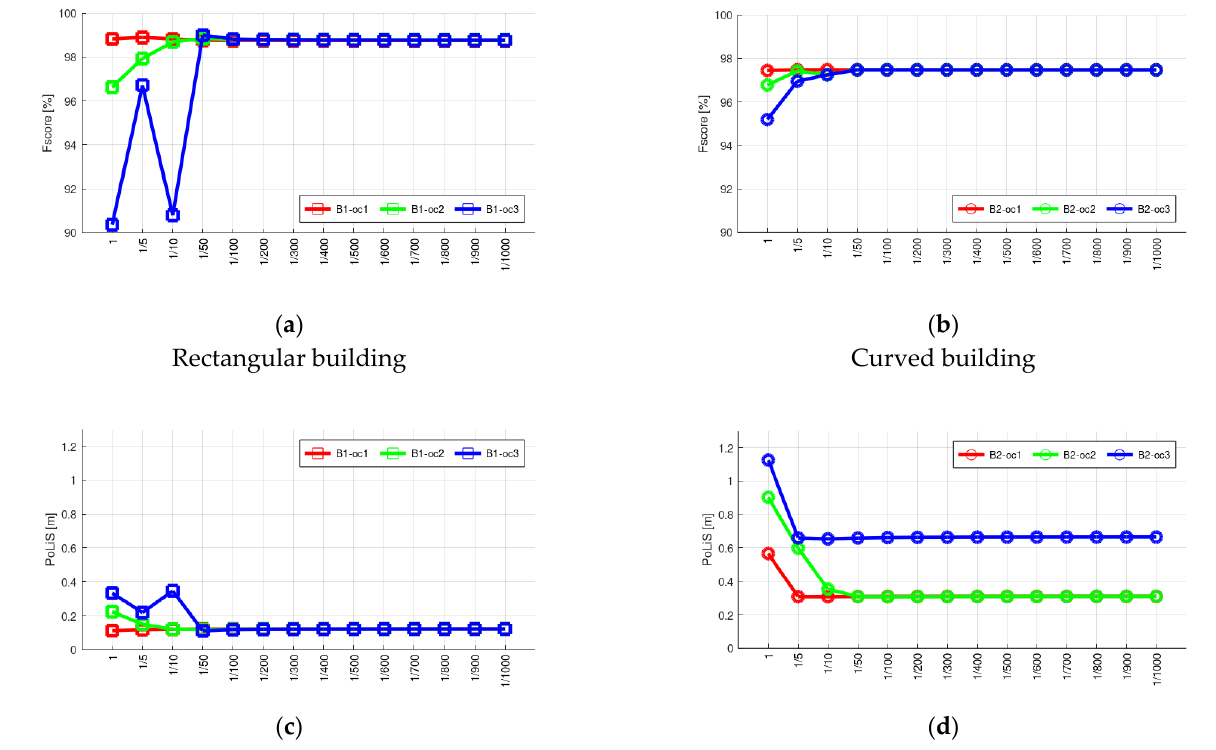
Figure 8. Quality metrics for rectangular ( a , c ) and curved ( b , d ) buildings with partial occlusions considering different weight values. F score ( a , b ) and PoLiS ( c , d ) metrics.